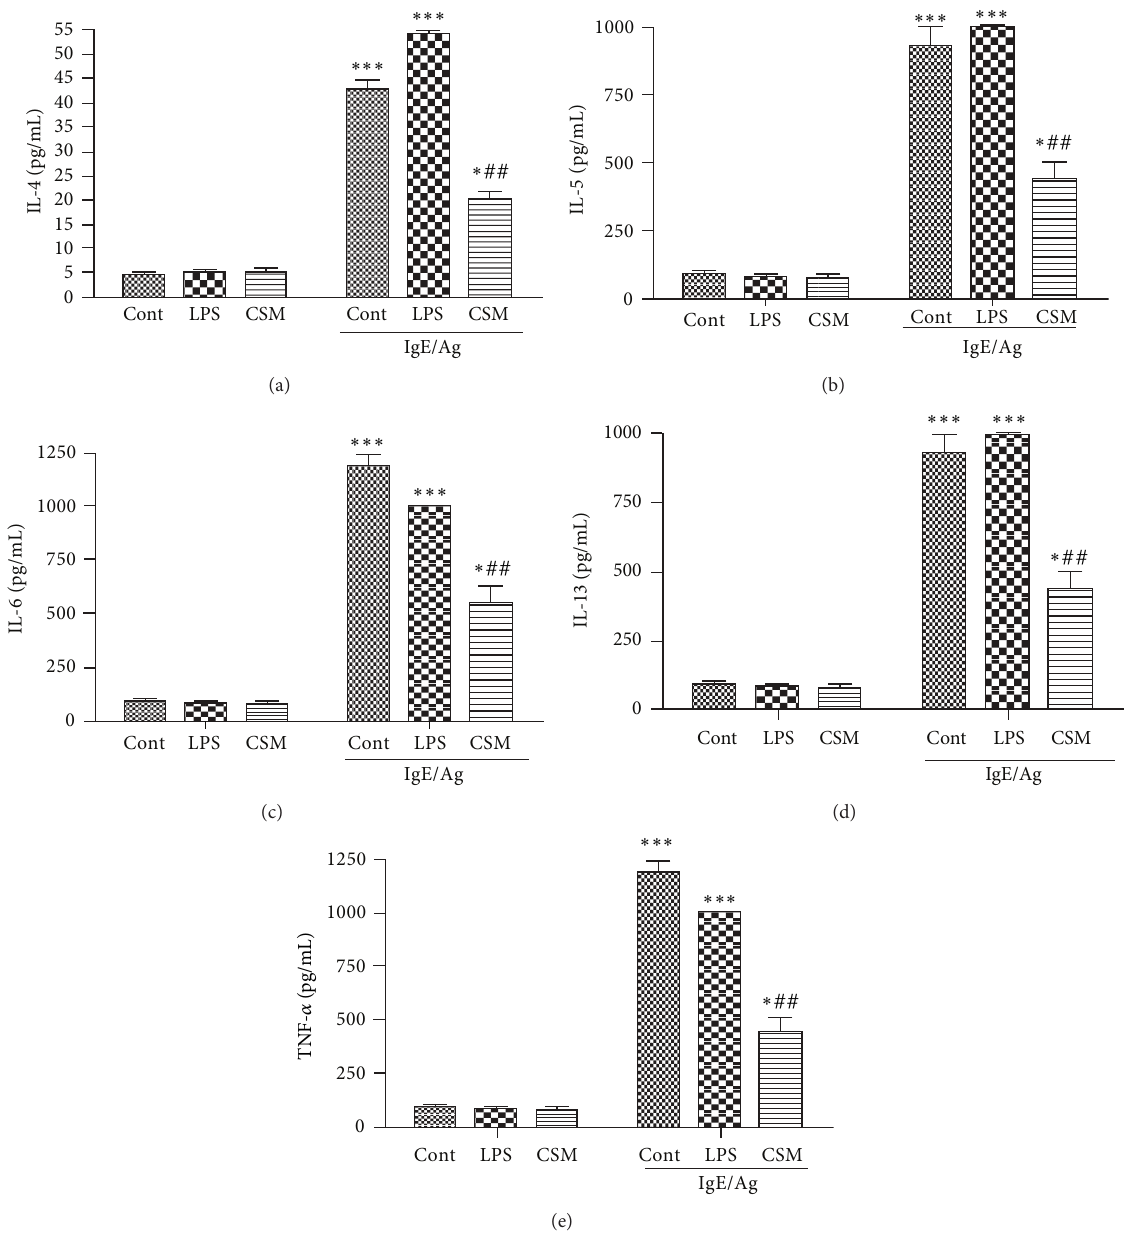
Figure 4: Long-term exposure of mast cells to CSM inhibits cytokine production by mast cells. BMMCs (control, CSM, and LPS cultured for 4–6 days) were sensitized with DNP-specific IgE, followed by activation with dinitrophenyl-conjugated ovalbumin (DNP-Ova) for 9h. The levels of cytokines IL-4 (a), IL-5 (b), IL-6 (c), IL-13 (d), and TNF- 𝛼 (e) in the supernatants were estimated by ELISA. Data are mean ± SEM of quadruplicate samples. The asterisks represent significant differences between nonactivated and activated cells ( ∗∗∗ 𝑃 < 0.001 ). Hatches represent significant differences between control mast cells and mast cells cocultured with CSM or LPS ( # 𝑃 < 0.05 and ## 𝑃 < 0.001